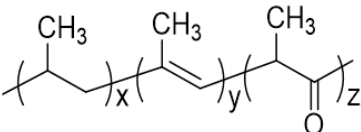
Figure 10. Proposed structure of the polypropylene (PP) chain changed by the plasma discharge from the original PP structure, as shown in Table 1.